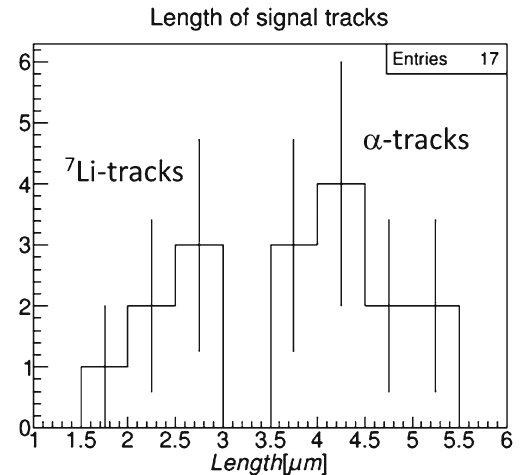
Fig. 4 A length distribution of 17 tracks randomly sampled from detected tracks. It is separated into two groups, the shorter one of 7 Li- tracks and the longer one of α -tracks. An error bar shows a statistical error for each bin